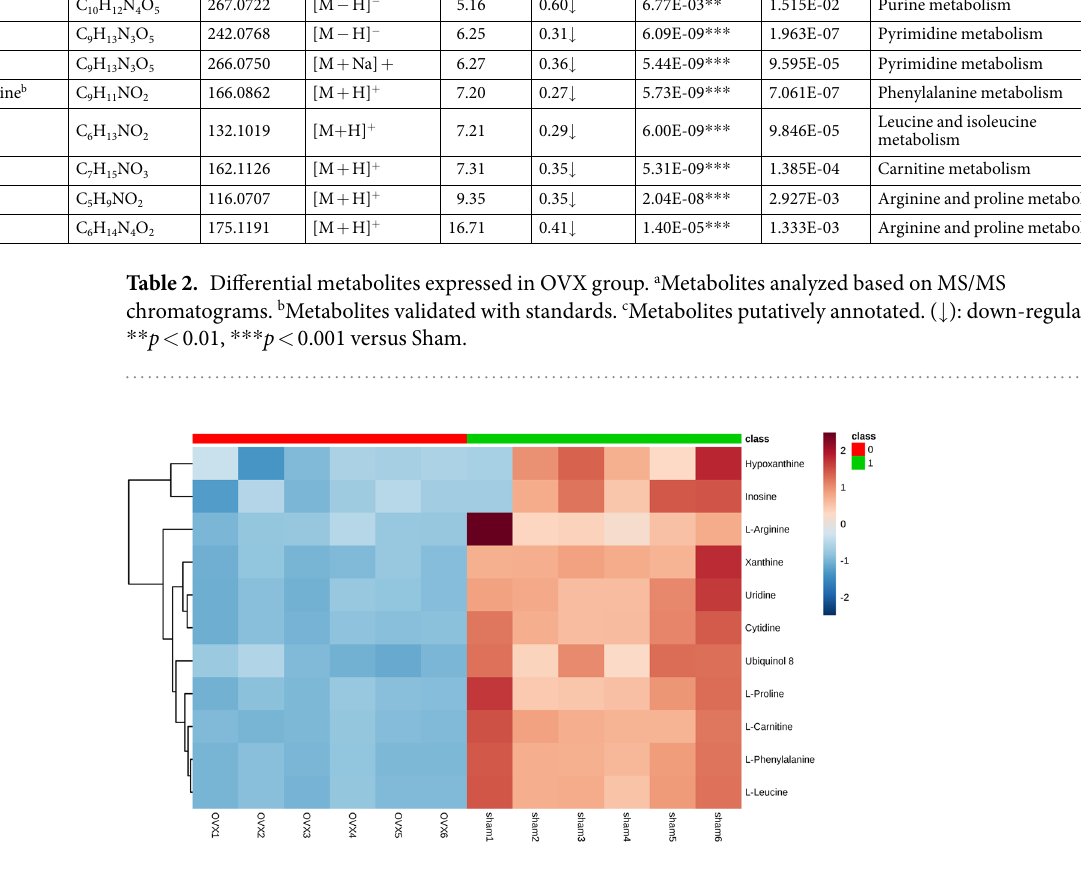
Figure 6. Heat map based on the relative levels of polar metabolites in femur of mouse in OVX. Class 0: OVX group, Class 1: Sham. Color key indicates metabolite expression value, red: up-regulated, blue: down-regulated.